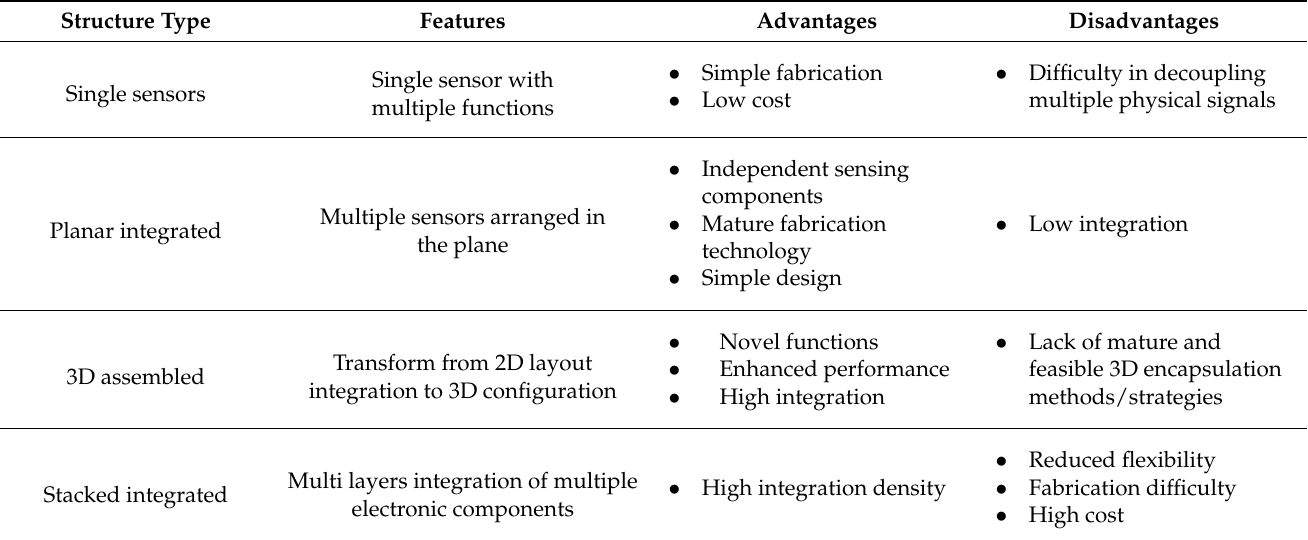
Table 2. Comparison of four types of multifunctional